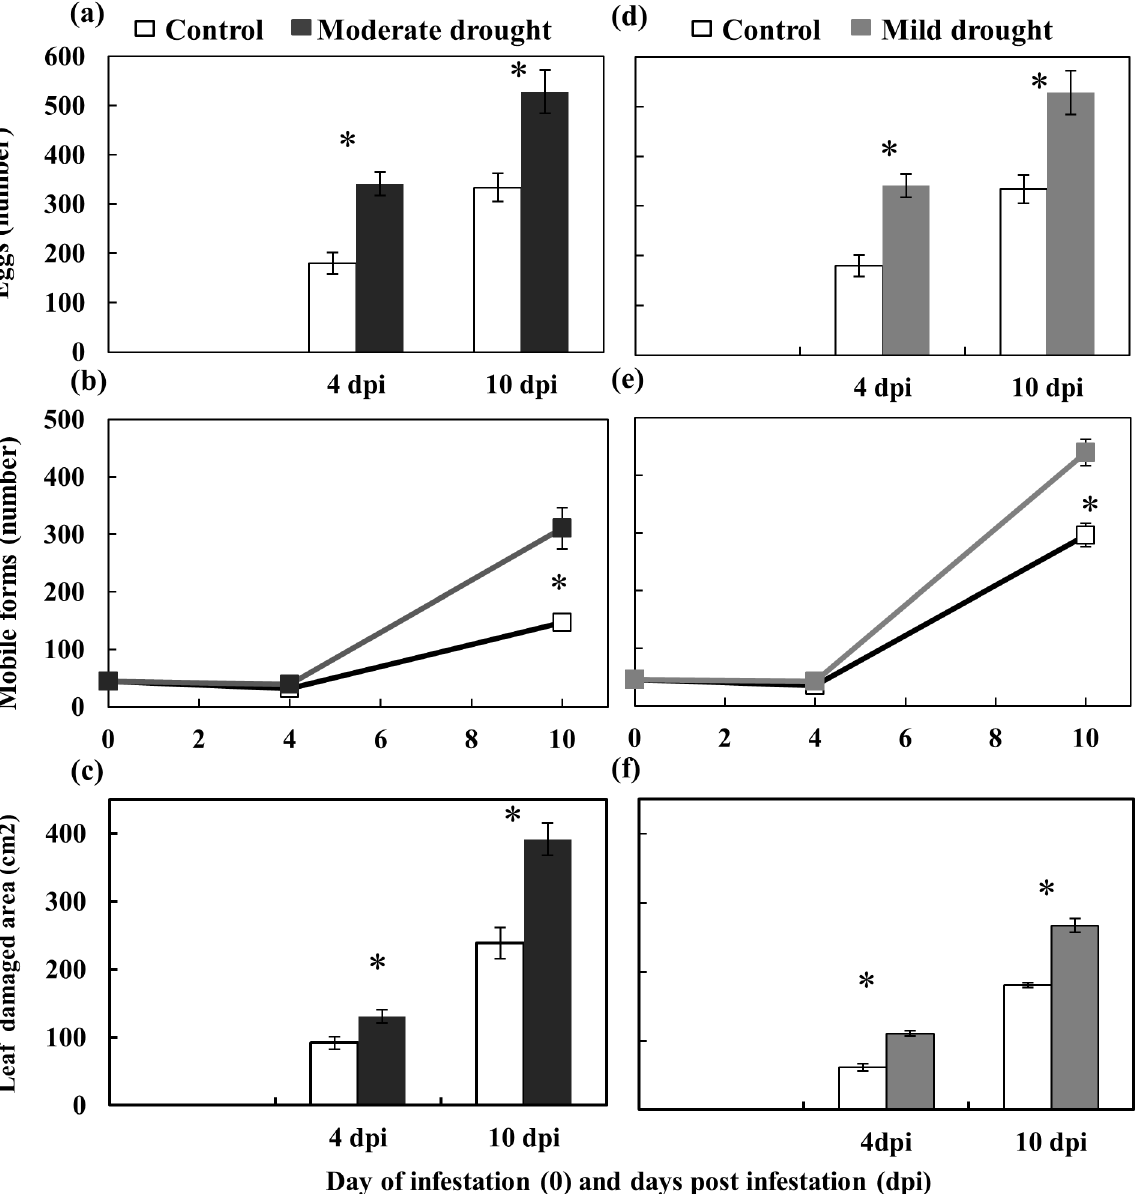
Fig 3. Performance of T . evansi in the moderate (a,b&c) and mild (d,e,f) drought stress experiments. The number of eggs (a&d), total mobile forms (b&e) and leaf damaged area (c&f) on control and drought stressed (mild or moderate) tomato plants at 4 and 10 days post infestation (dpi) were measured. Data are mean ± SE. * indicates a statistically significant difference within each time (Two-way ANOVA, Bonferroni post hoc test, P <